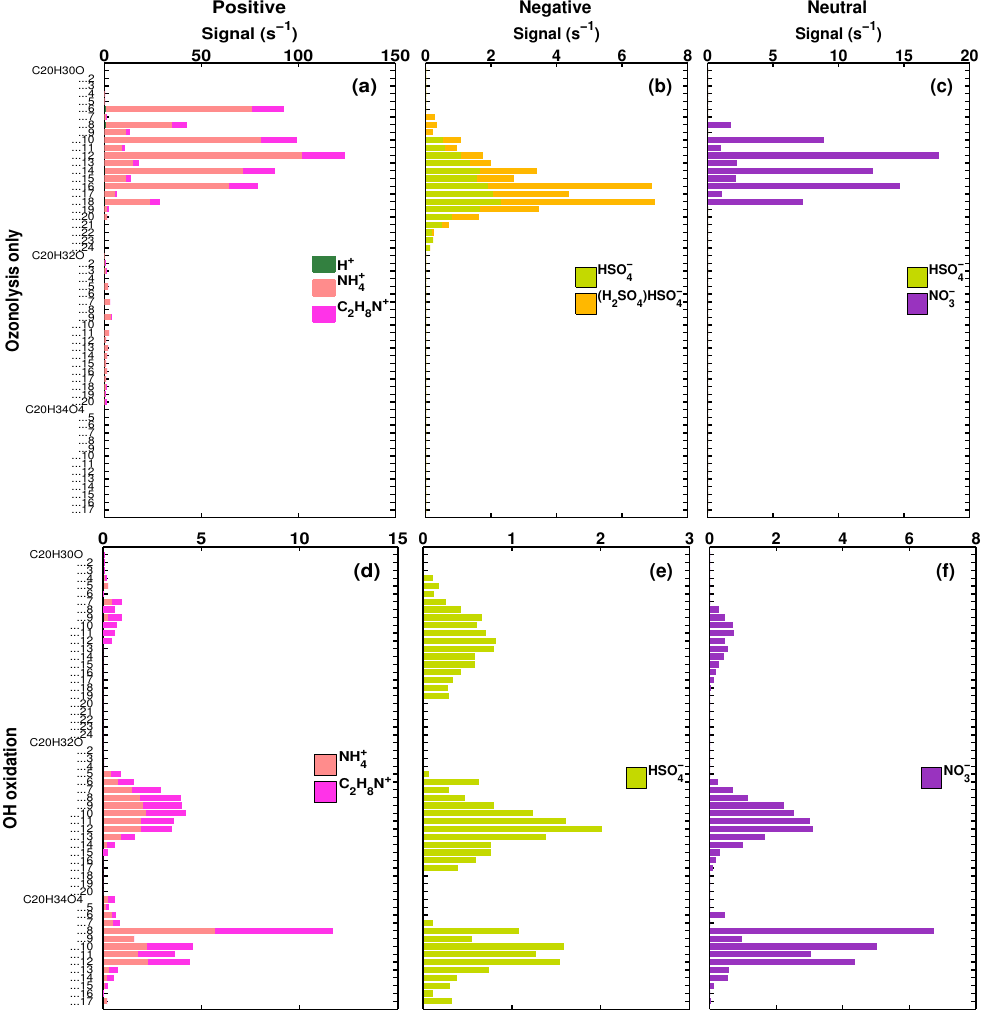
H O 20 b c according to core ion(s)